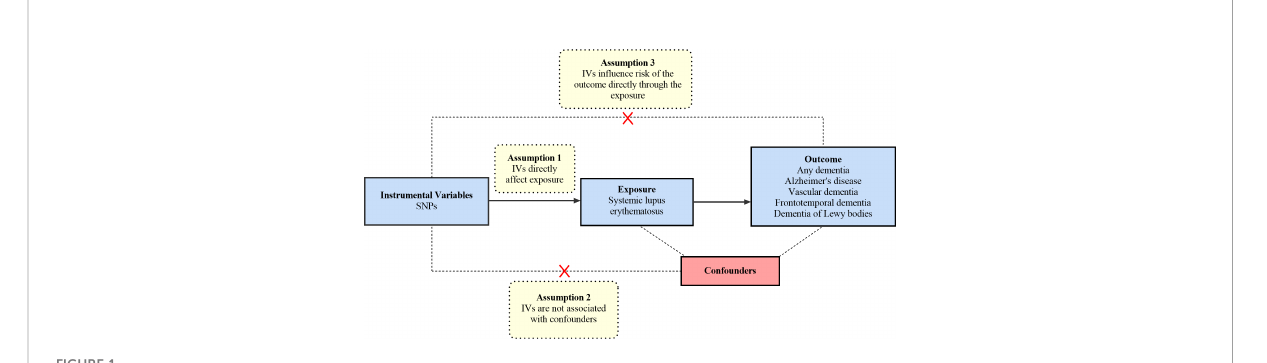
FIGURE 1 An overview of the study design. SNP, single nucleotide